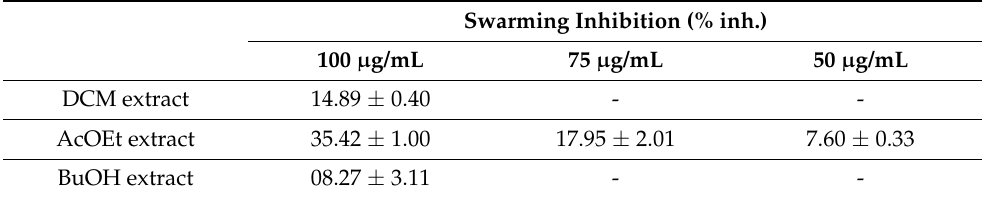
Table 3. Anti-swarming activities of C. nepeta extracts on P. aeruginosa PA01. Swarming Inhibition (%